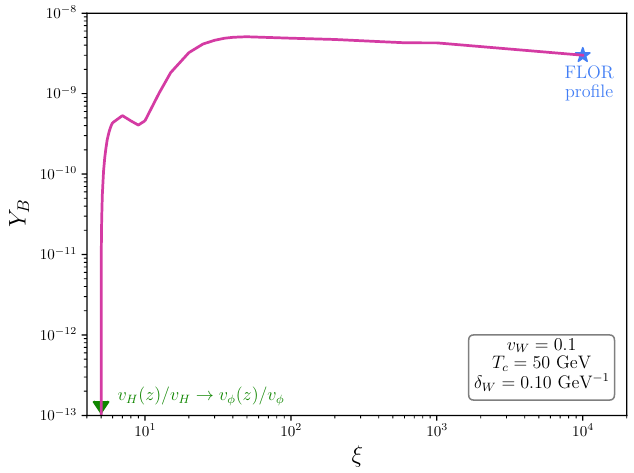
Figure 11 . Generated Y B as a function of (cid:24) as de(cid:12)ned in eq. (3.13) for a benchmark point. The blue star corresponds to the asymmetry generated using the FLOR pro(cid:12)le, while the green triangle points towards the limiting case in which both vev pro(cid:12)les have the same shape where no asymmetry is generated. The masses of the heavy neutrinos in this particular case are M 1 = 80 GeV, M 2 = 90 GeV and M 3 = 100 GeV while m D has been (cid:12)xed as discussed at the end of section